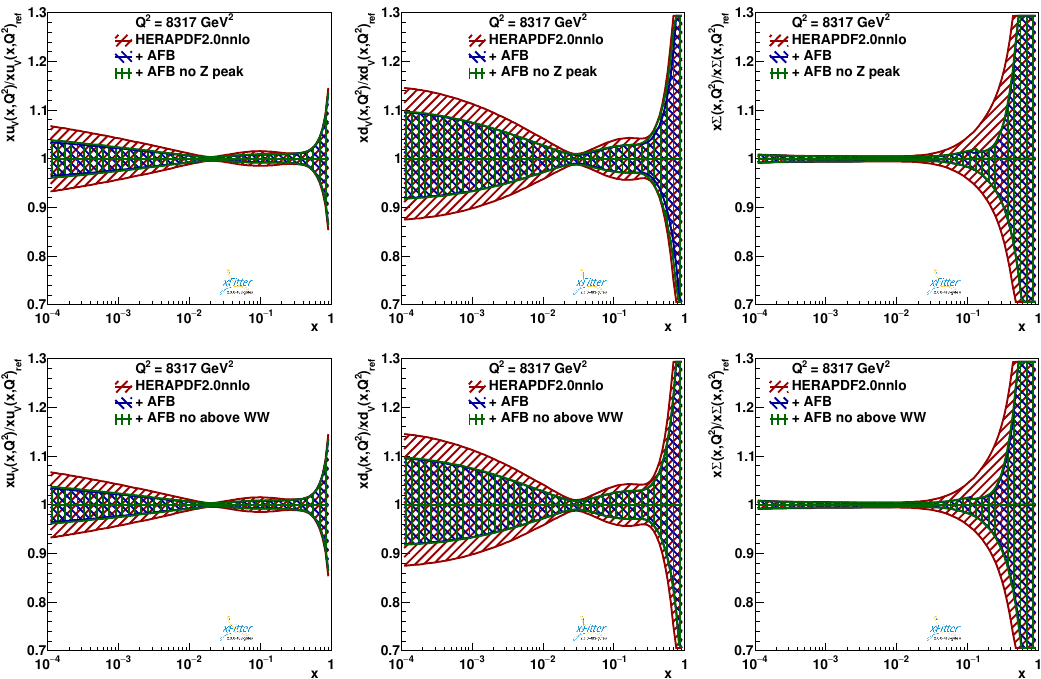
Figure 10 . Pro(cid:12)led curves obtained with the HERAPDF2.0nnlo using the full set of data, and when removing the data in the invariant mass region around the Z peak (top row) and when removing the data in the invariant mass region above WW production threshold (bottom row). The pseudodata corresponds to an integrated luminosity of 3000 fb (cid:0) 1 .